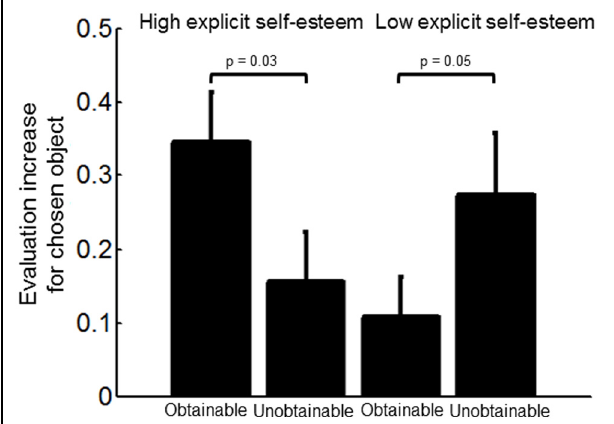
FIGURE 2 | Interaction between the factors evaluation change of chosen objects according to their obtainibility (ECS-1-M versus ECS-2-M) and explicit self-esteem (Low versus High group; 2x2 ANOVA). Participants in the high explicit self-esteem group showed more evaluation change of chosen objects when they were obtainable [one-tailed paired t -test, t (26) = 2.02, p = 0.03] while those in the low explicit self-esteem group showed increased preference for chosen objects that were unobtainable [one-tailed paired t -test, t (26) = − 1.67, p = 0.05]. Error bars represent